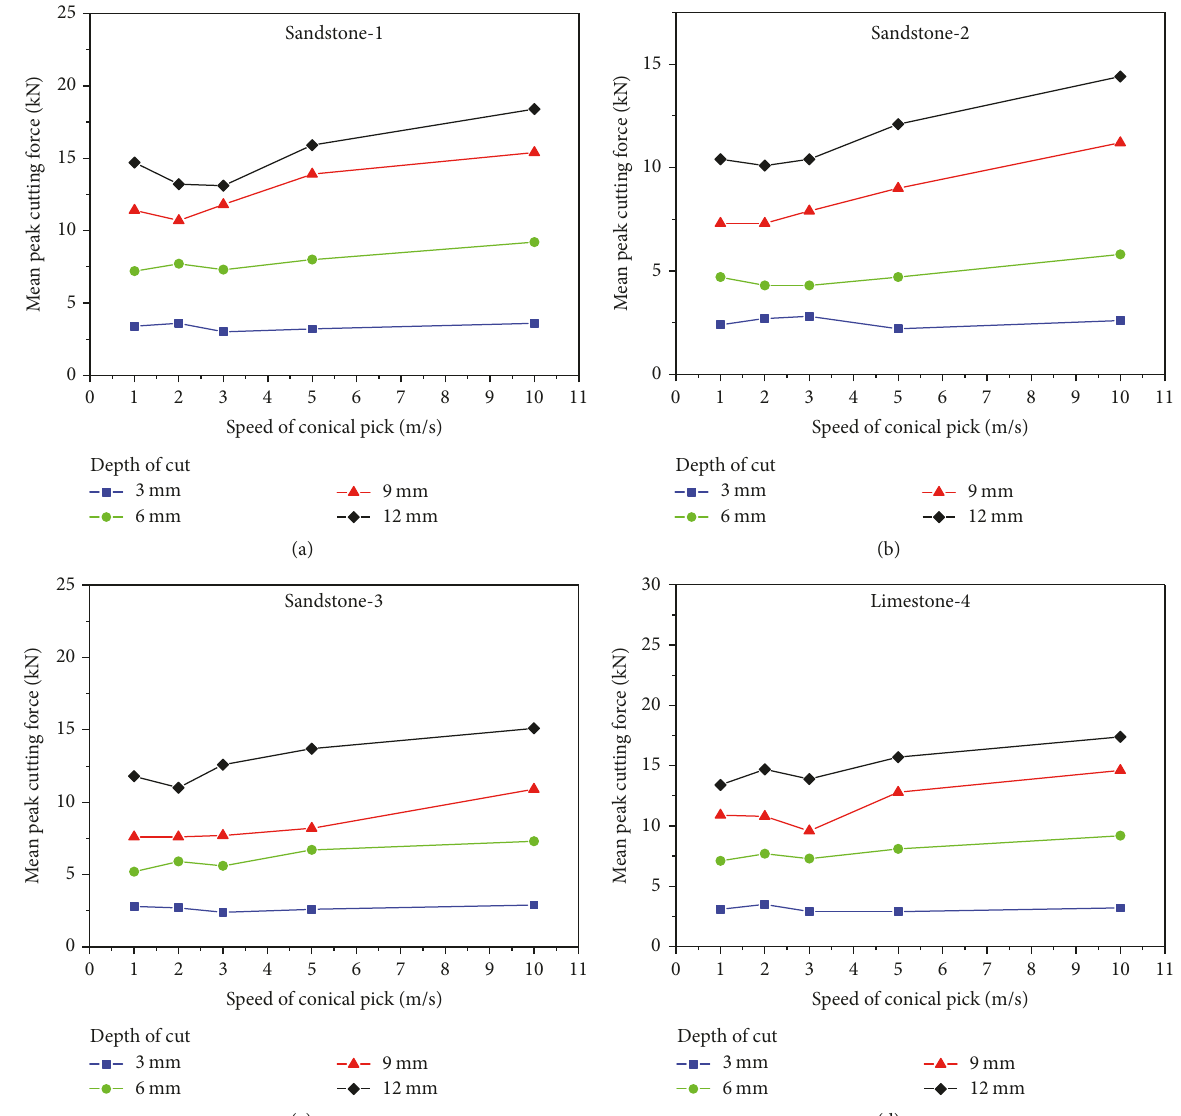
Figure9:Thevariationinthemeanpeakcuttingforcewiththespeedoftheconicalpickfordeferentrocktypes:(a)sandstone-1,(b)sandstone- 2, (c) sandstone-3, and (d)